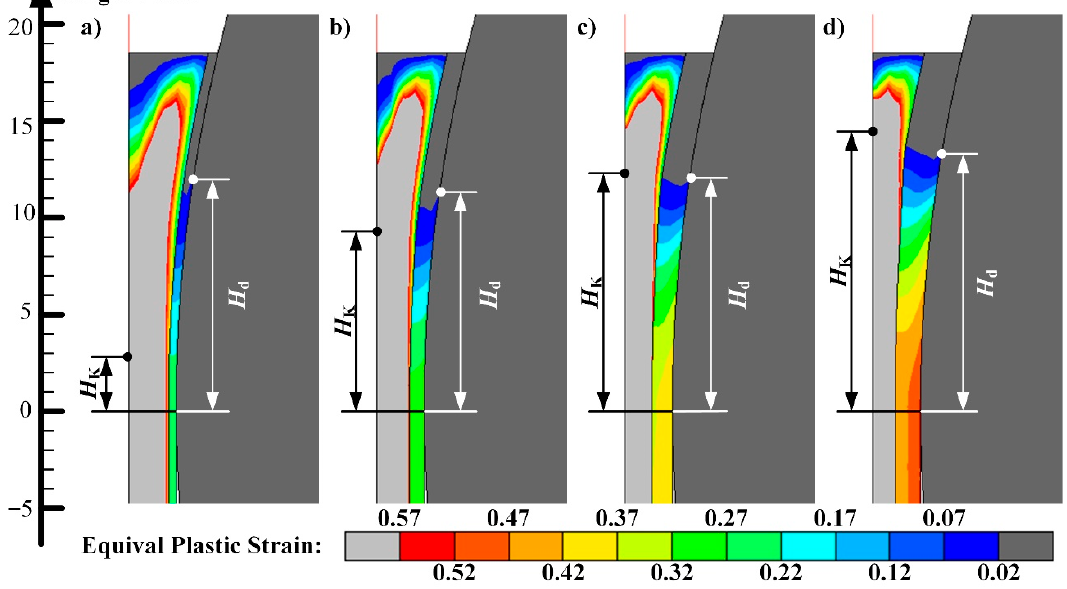
Figure 7. Contour bands of SLS-TRC strain distribution with different clad thickness. ( a ) H 1060 = 0.5 mm; ( b ) H 1060 = 1.0 mm; ( c ) H 1060 = 1.5 mm; ( d ) H 1060 = 2.0 mm.